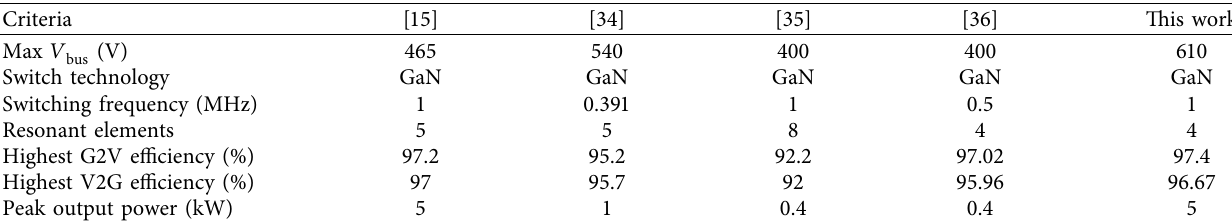
Figure 17: Comparative analysis of the proposed converter in terms of (a) highest G2V (charging) mode efciency, (b) highest V2G (discharging) mode efciency, and (c) output load current. Table 3: Performance comparison with existing